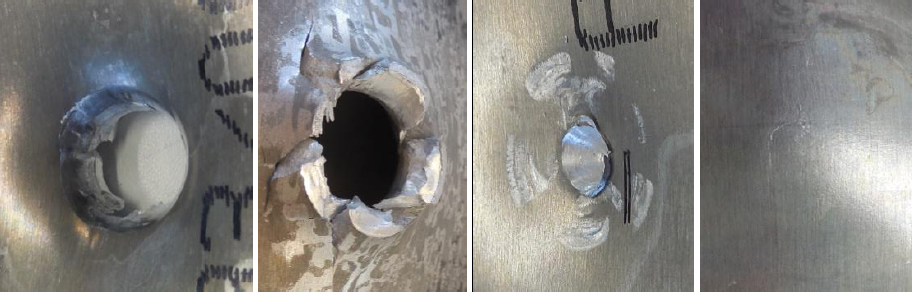
Fig. 2. Test on a multi-layered protection system at 226 m/s. From left to right: front face of the front plate, rear face of the front plate, front face of the rear plate, rear face of the rear